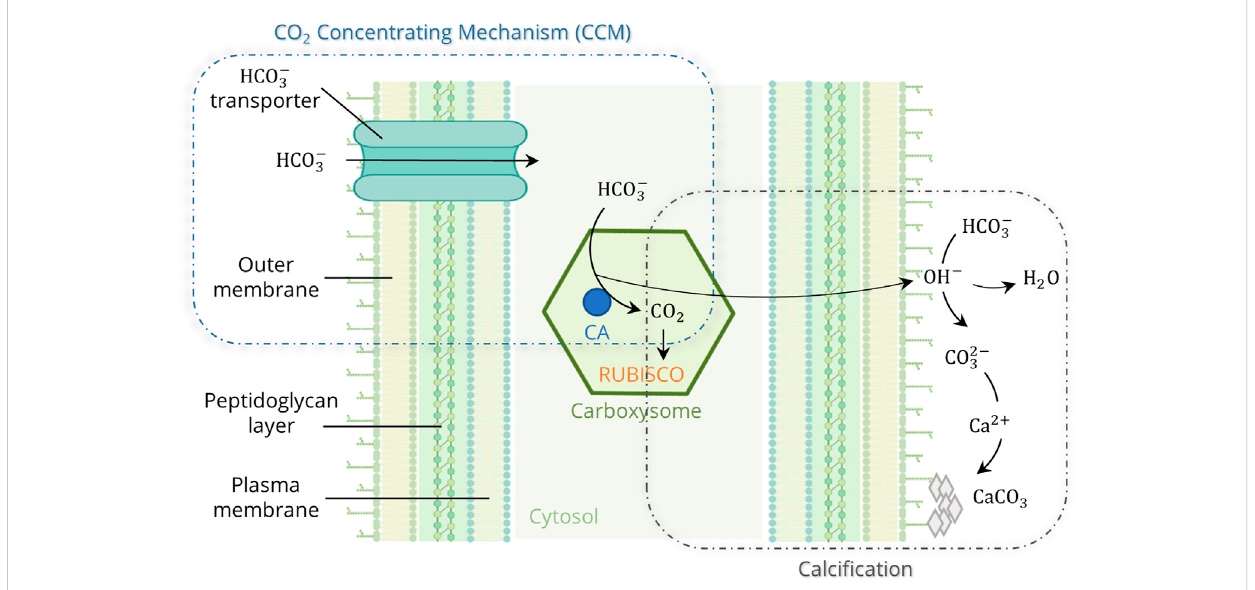
FIGURE 1 Model of the cyanobacterial calci fi cation, enhanced by photosynthetic CO 2 Concentrating Mechanisms (CCM) (created in BioRender.com; modi fi ed from Riding, 2006 and Kamennaya et al.,